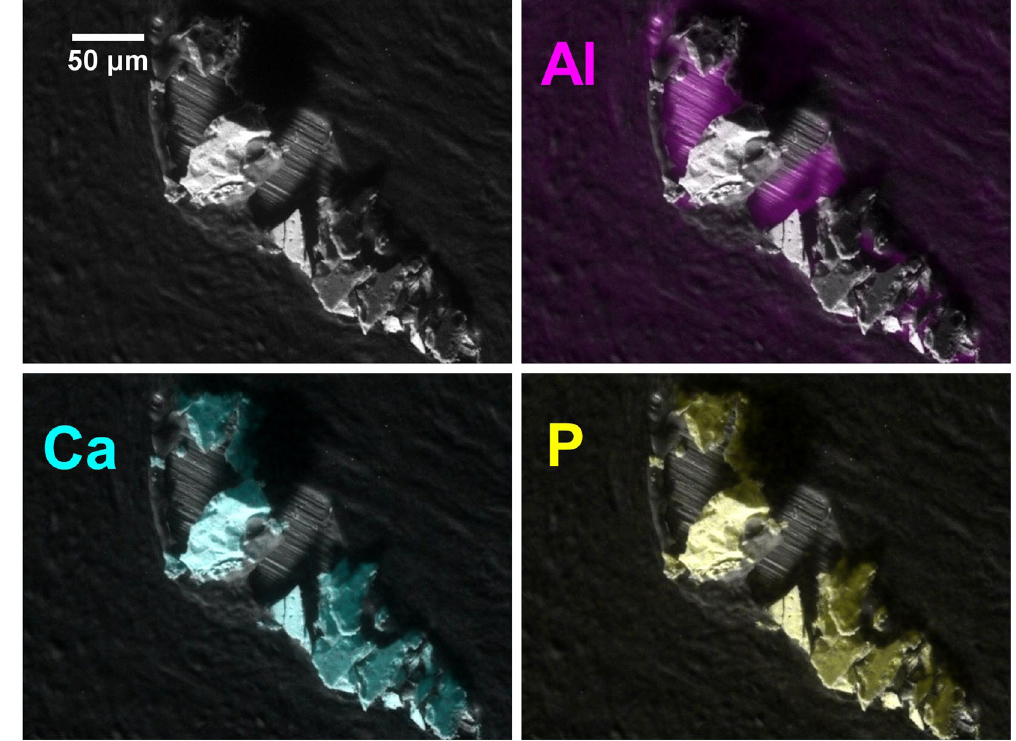
Figure 2. SEM image of a highly fragmented calcification. Note the shadowing of the substrate in the Al image. (Specimen S59 - pathology details in Supplementary Table A).